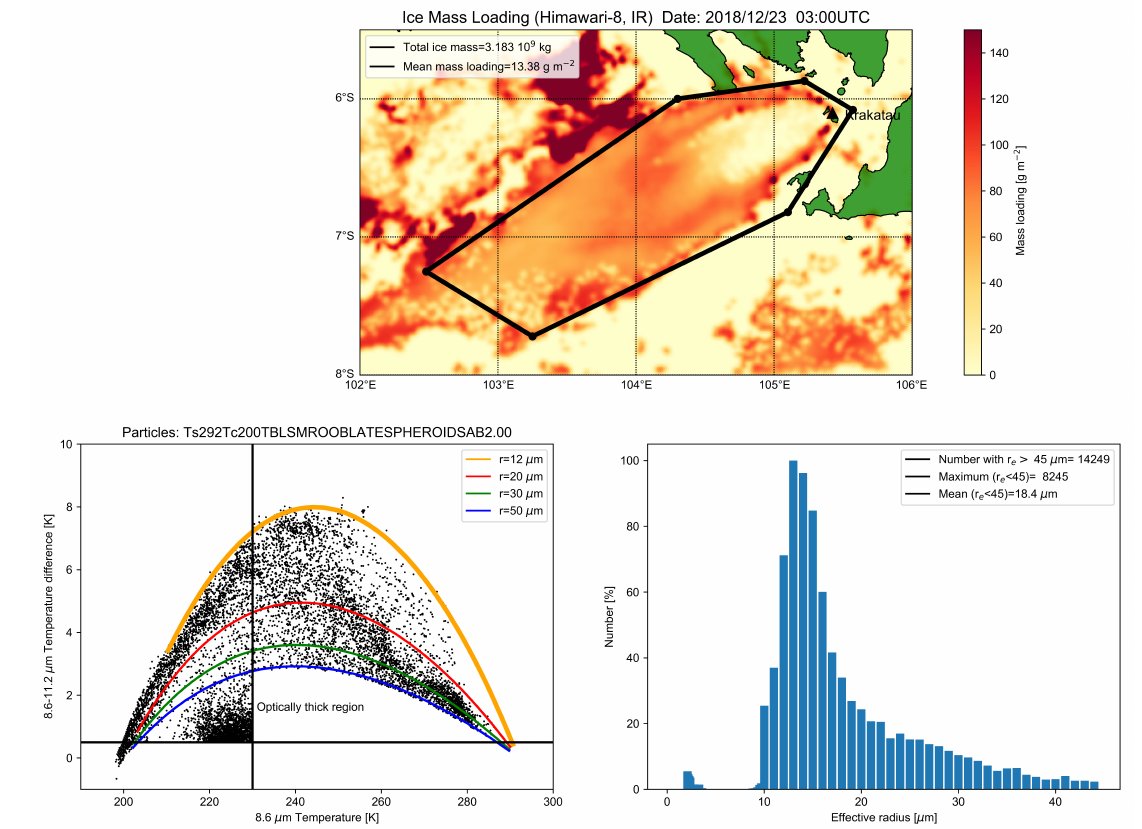
Figure 19. Analysis of ice particles from the eruption cloud of Anak Krakatu on 23 December 2018 at 03:00 UTC. Top: Ice mass retrievals using the ART model with oblate spheroidal ice particles. Bottom left: Temperature difference curves using 8.6 and 11.2 µ m brightness temperatures. Bottom right: Retrieved effective radius particle size distribution. Satellite data are from Himawari-8 courtesy of JAXA/JMA.